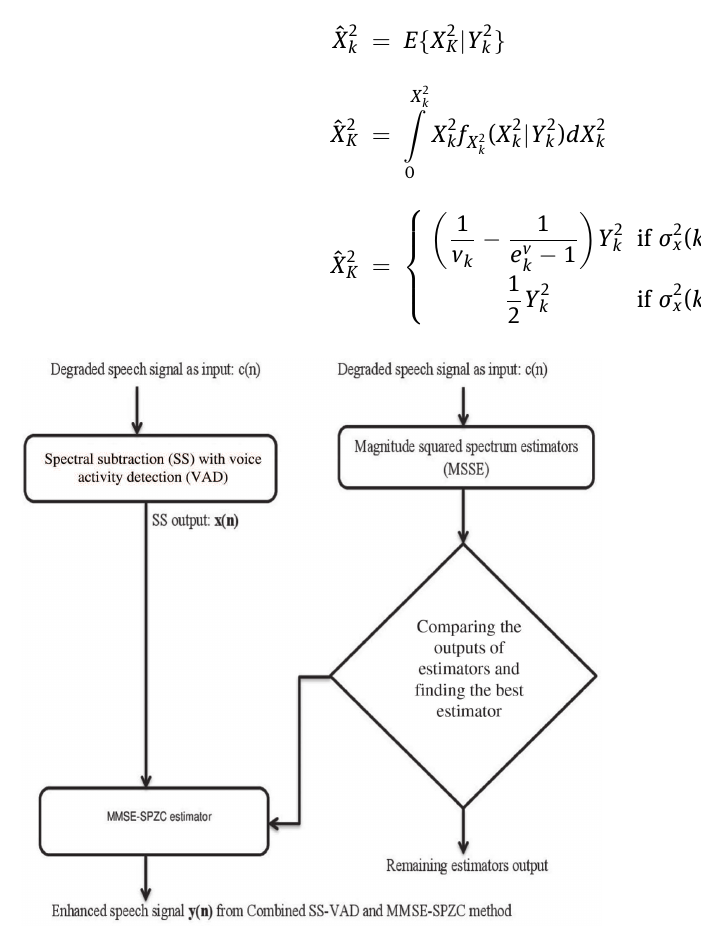
Figure 4: Flow Chart of Combined SS-VAD and MMSE-SPZC